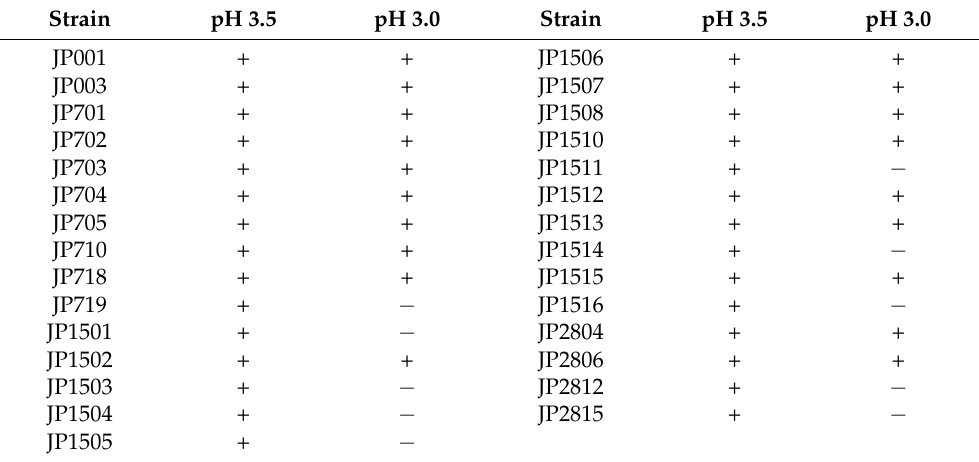
Table 1. Screening of acid-resistant strains of 29 LAB strains. Strain pH 3.5 pH 3.0